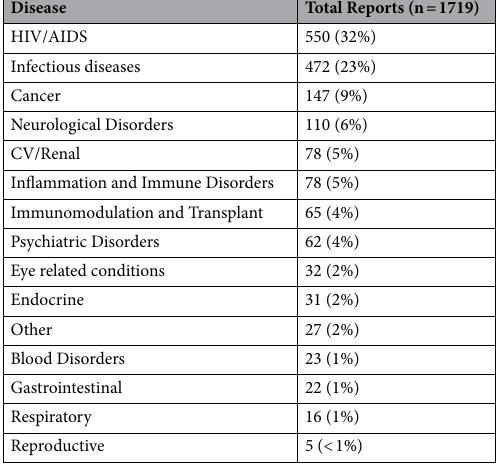
Table 2. Frequency of co-occurring diseases with Toxoplasma infections in FAERS